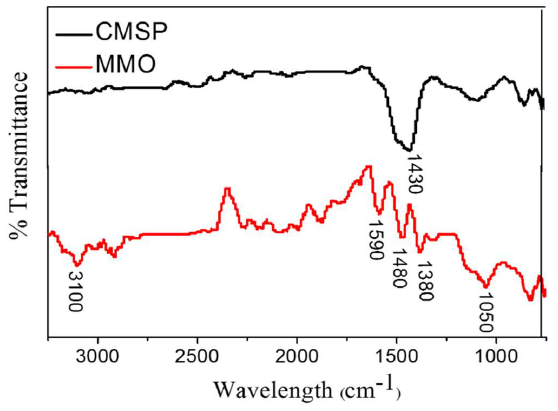
Figure 5. FTIR spectra of as-prepared sample CMSP and MMO.